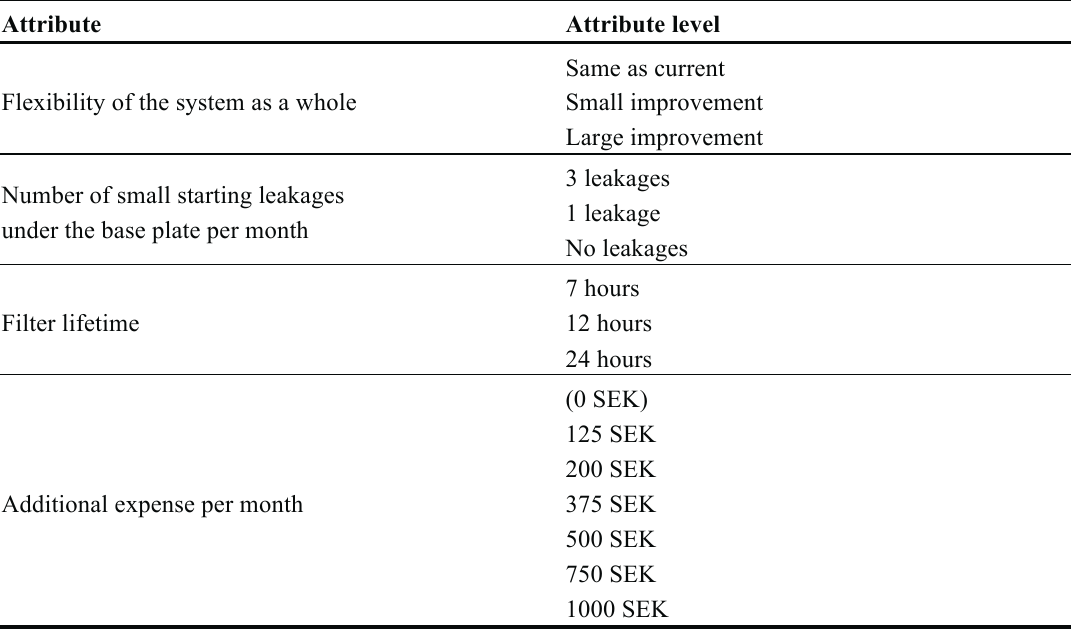
Table 1: Attributes and attribute levels